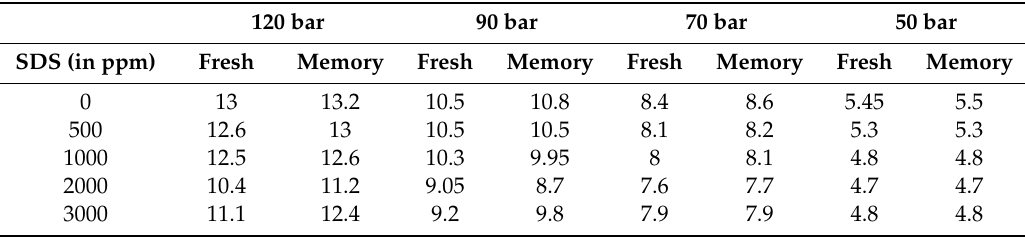
Table 3. Onset of nucleation temperature T 0 ( ◦ C) vs. SDS concentration at di ff erent pressures from 50 bar to 120 bar.